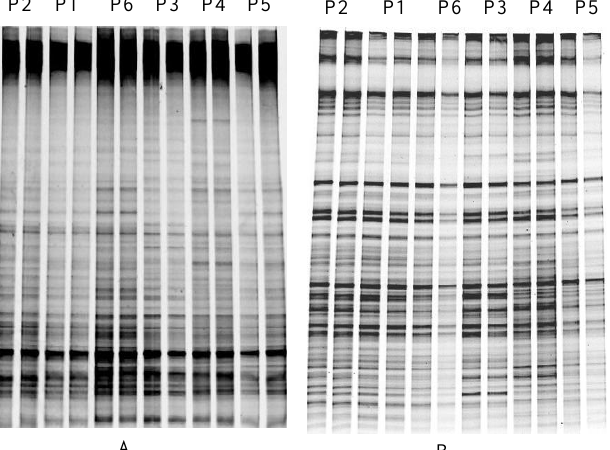
Figure 3. DGGE profiles of soil bacteria ( A ) and actinomycetes ( B ) communities from different soil samples.